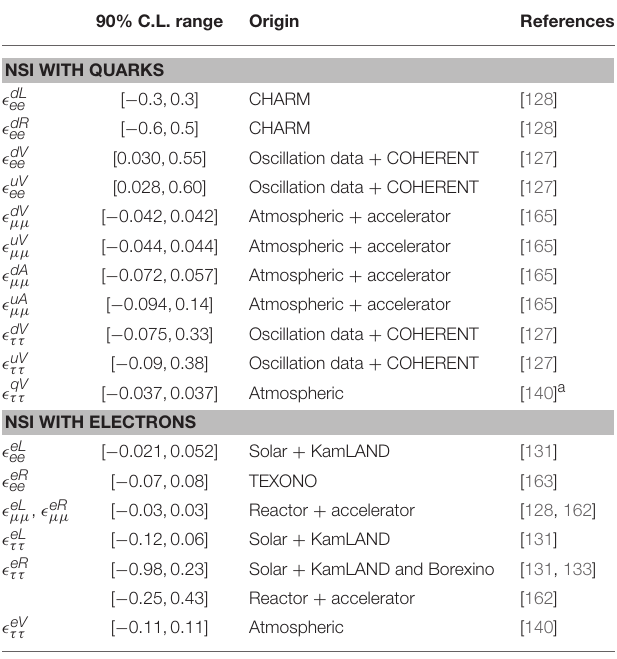
TABLE 2 | Bounds on flavor diagonal NC NSI couplings.